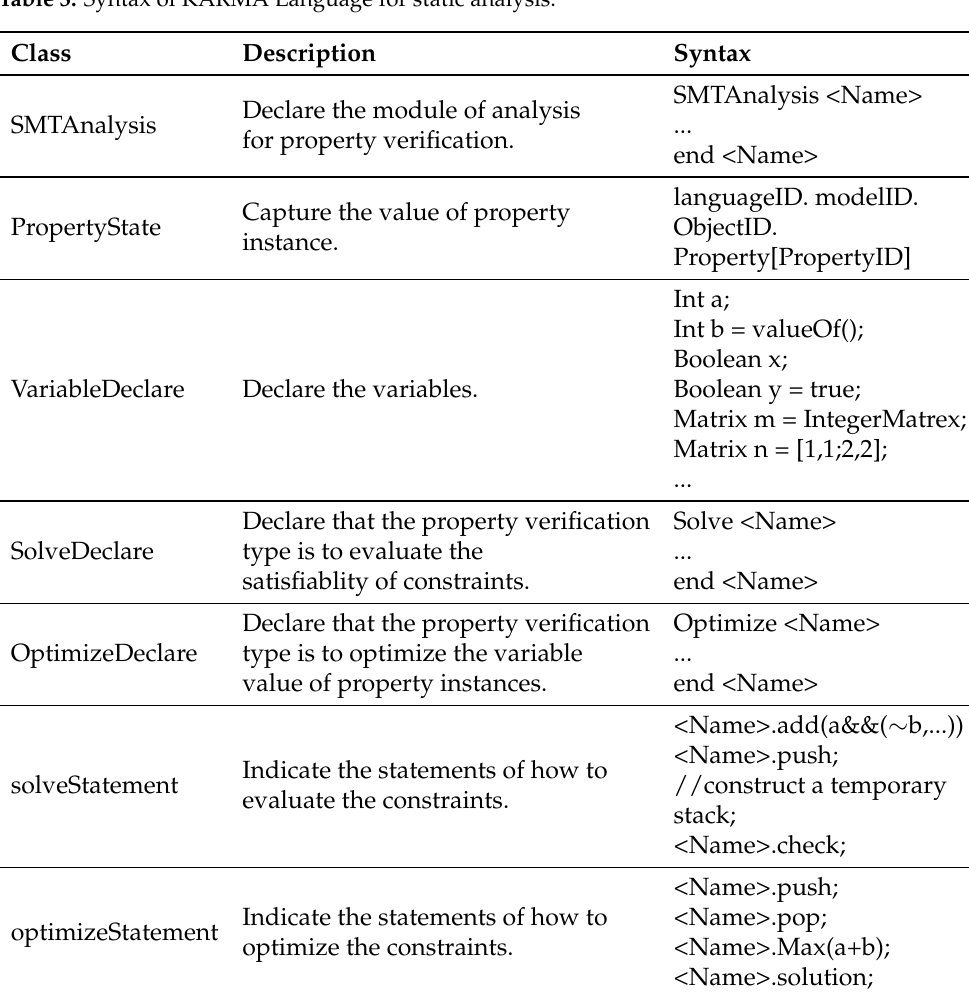
Table 3. Syntax of KARMA Language for static